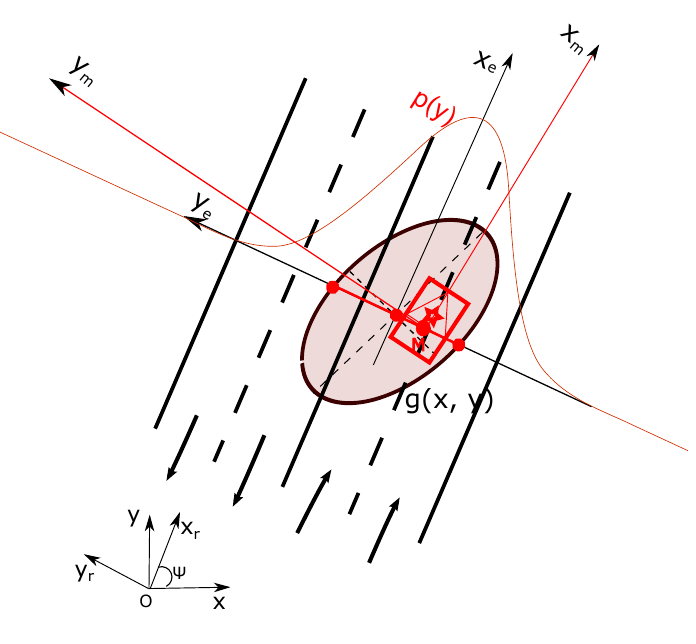
Figure 4. Uncertainty of the estimated